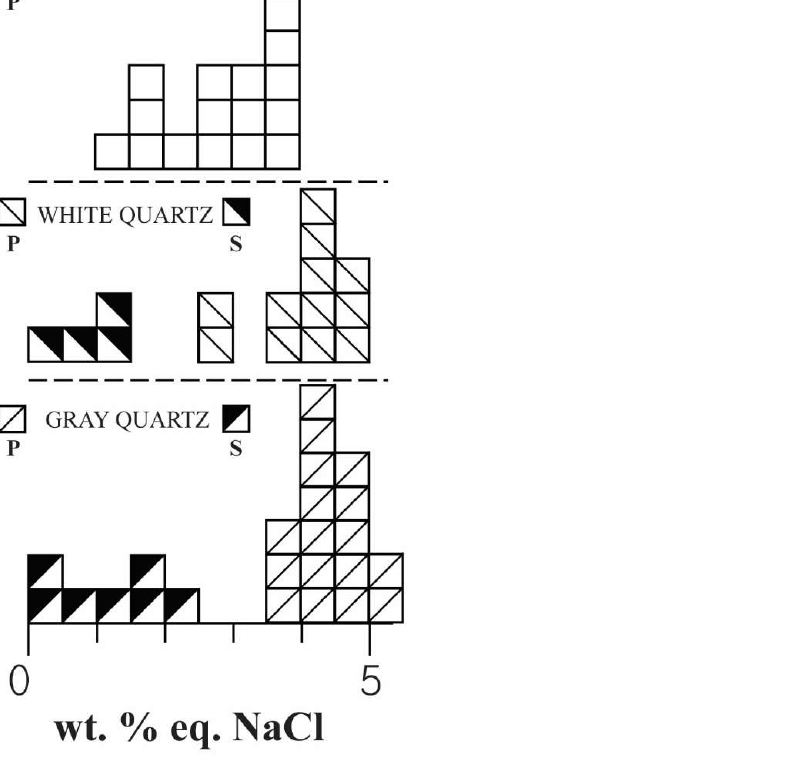
Figure 10. Salinity histograms of fluid inclusions in vein minerals of stage II from the Eunjeok Au–Ag deposit. Abbreviations: P = primary, S = Secondary.